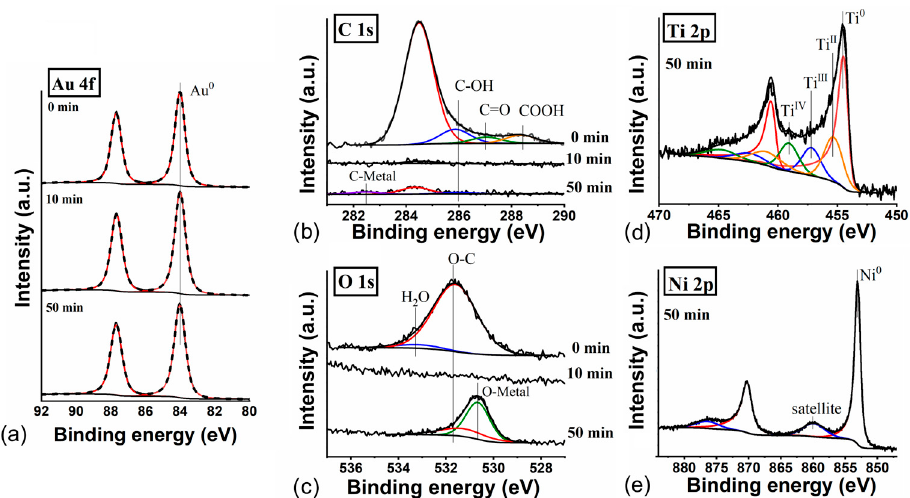
Figure 7. XPS spectra of Au/TiNi sample at different Ar + etching times: ( a ) Au 4f; ( b ) C 1s; ( c ) O 1s; ( d ) Ti 2p; and ( e ) Ni 2p.